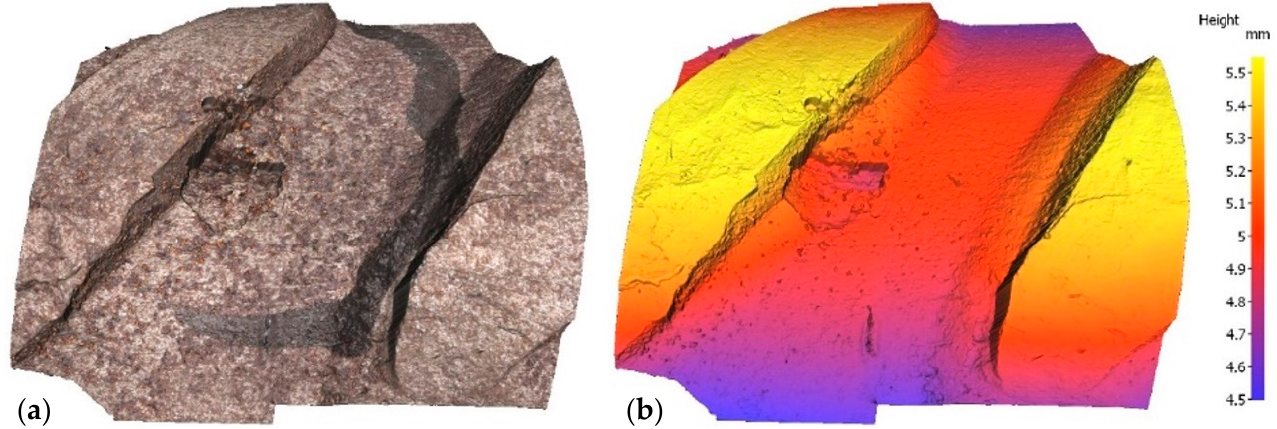
Figure 3. Pit in specimen E12: ( a ) natural colour; ( b ) depth-based colour coding.